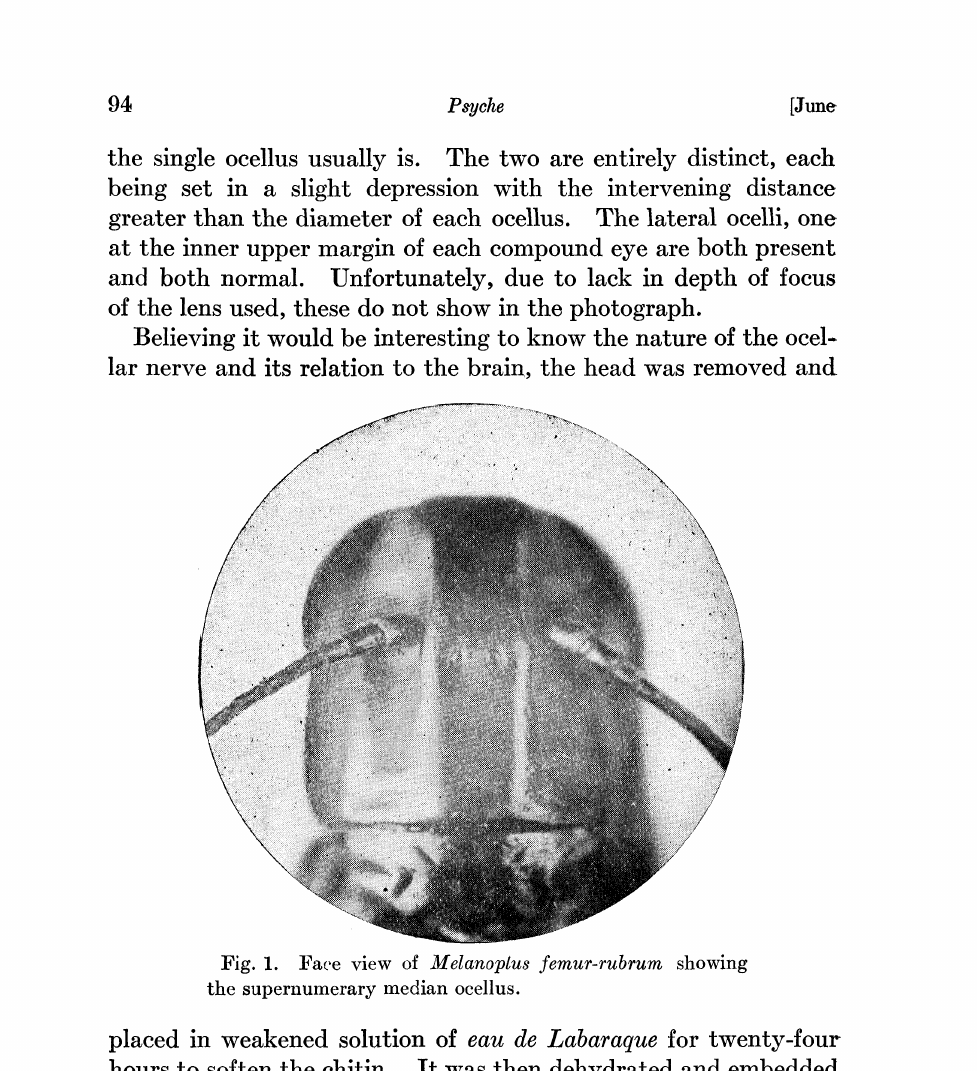
Fig. 1. Face view of Melanoplus femur-rubrum showing the supernumerary median